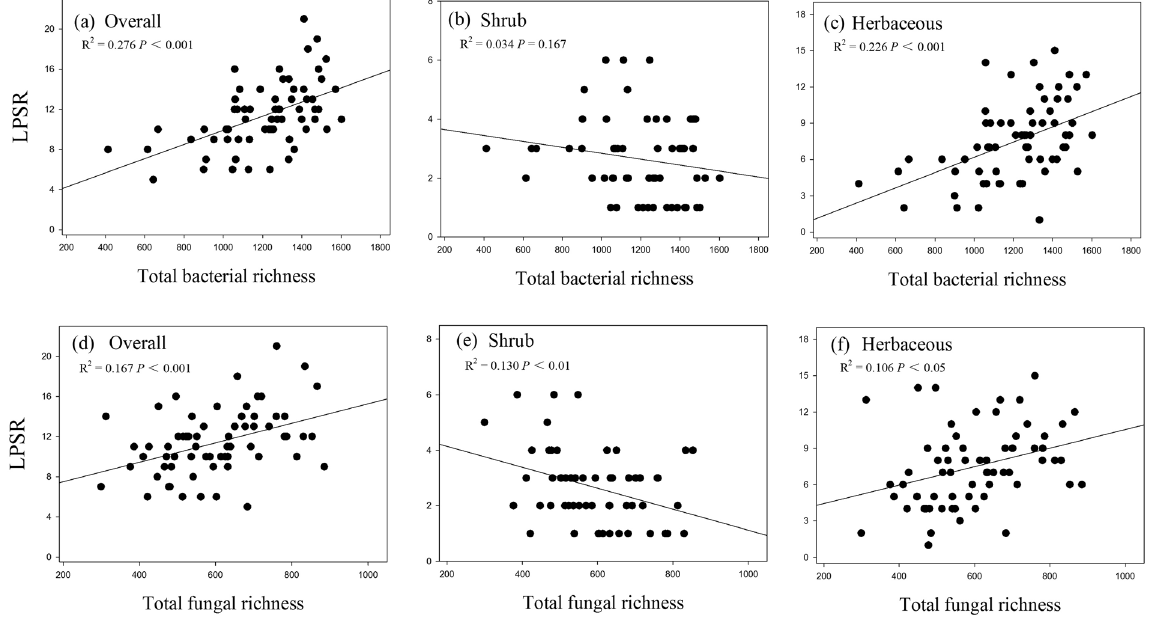
Figure 3. Relationships between the overall, shrub, and herbaceous LPSR and soil total bacterial ( a – c ) and fungal ( d – f ) richness.